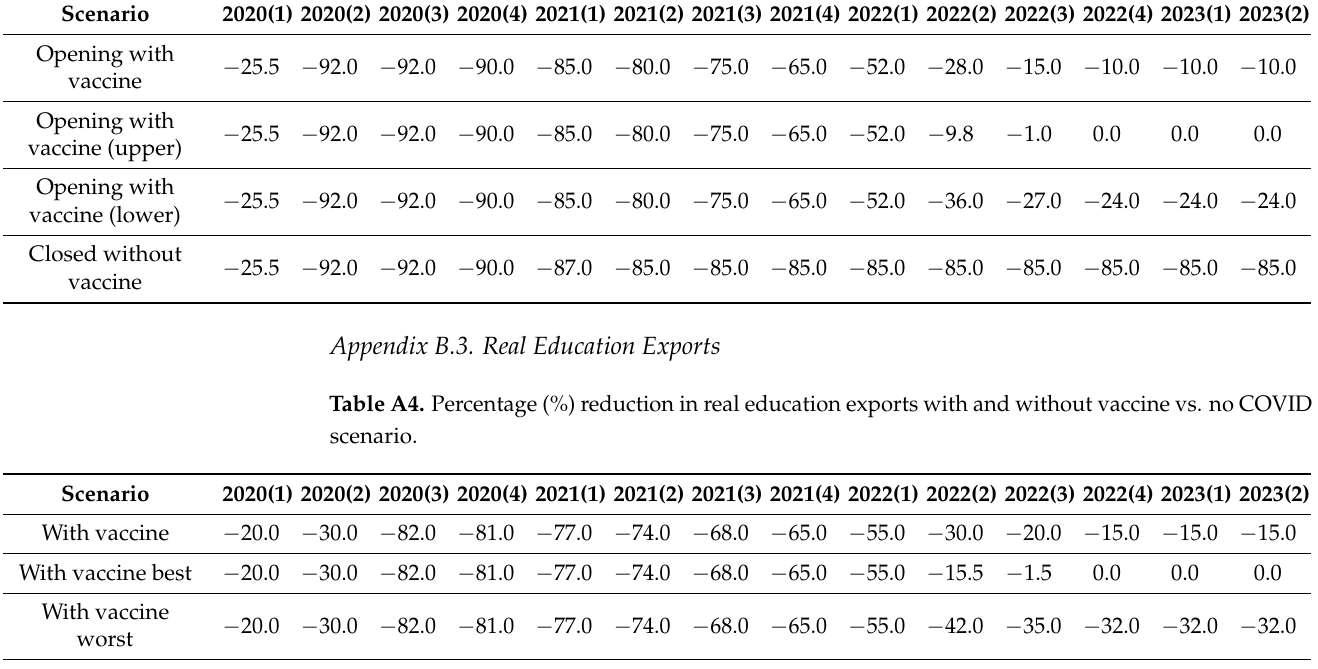
Table A3. Percentage (%) reduction in real tourism exports with and without vaccine vs. no COVID scenario.